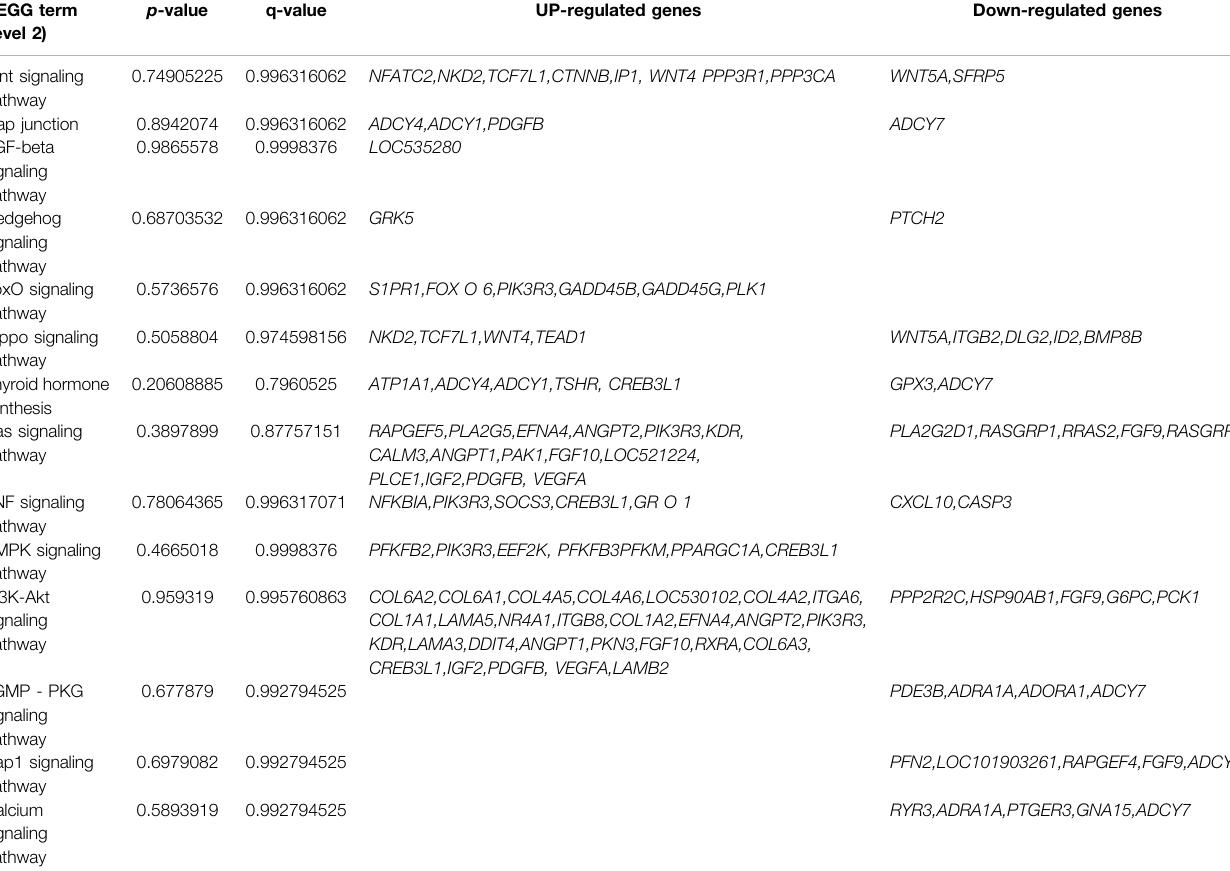
TABLE 3 | Partial KEGG pathway related